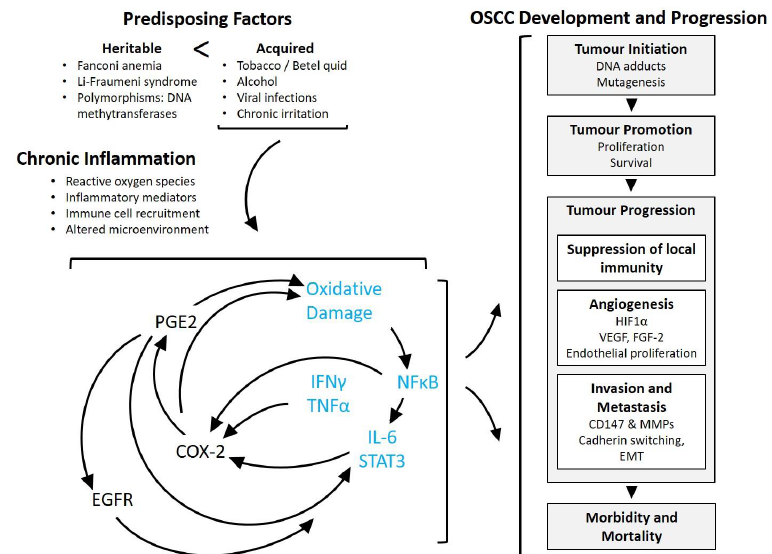
Figure 2. General role of PGE2-mediated inflammation in oral and oropharyngeal squamous cell carcinoma (OSCC) development and progression. Most cases of OSCC are attributable to acquired risk factors that are dominated by long-term tobacco and alcohol use, and infection with high risk human papillomavirus (HPV), rather than germline mutations. Infection and mechanical or chemical factors leads to chronic inflammation accompanied by oxidative damage and genetic and epigenetic alterations. In general, chronic inflammation is driven by a cycle of increased expression of mediators, including (but not limited to) PGE2, IFN γ and TNF α ; arising from immune cells, stromal cells and tumour cells. PGE2 synthesis is chiefly attributed to COX-2 in OSCC. COX-2 activity and PGE2 have been shown to contribute to oxidative damage, increased expression of inflammation-associated transcription factors, and altered gene expression. Demonstrated outcomes of COX-2/PGE2 activity include activation of EGFR signalling, increased HIF1 α and VEGF, and increased activity of CD147 and MMP enzymes. Collectively, chronic inflammation contributes to OSCC at various stages from initiation of carcinogenesis through invasion and metastasis, ultimately contributing to patient morbidity and mortality. Blue text signifies hypothesised mechanisms based on studies in other forms of cancer. COX-2 (cycloxygenase-2), PGE2 (prostaglandin E2), EP1-4 (PGE2 receptors 1 though 4), NF κ B (nuclear Factor kappa-light-chain-enhancer of activated B cells), IL-6 (interleukin 6), STAT3 (signal transducer and activator of transcription 3), IFN γ (interferon γ ), TNF α (tumour necrosis factor α ), EGFR (epidermal growth factor receptor), HIF1 α (hypoxia inducible factor 1 α ), VEGF (vascular endothelial growth factor), FGF-2 (fibroblast growth factor 2), CD147 (cluster of differentiation factor 147), MMP (matrix metalloproteinase), EMT (epithelial to mesenchymal